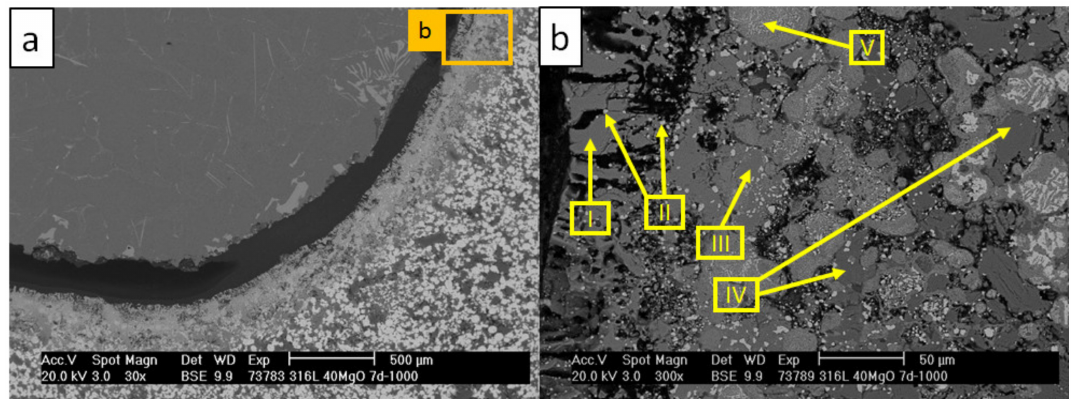
Figure 14. SEM micrographs of the C_1000 composite crucible after the corrosion test with molten